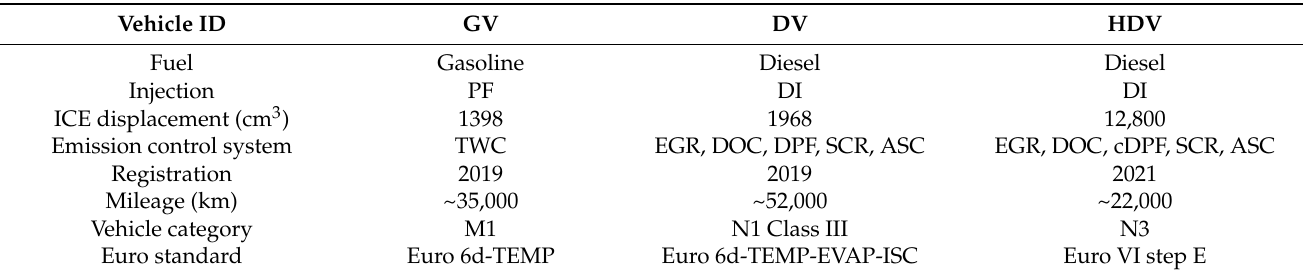
Table 1. Summary of vehicles tested.